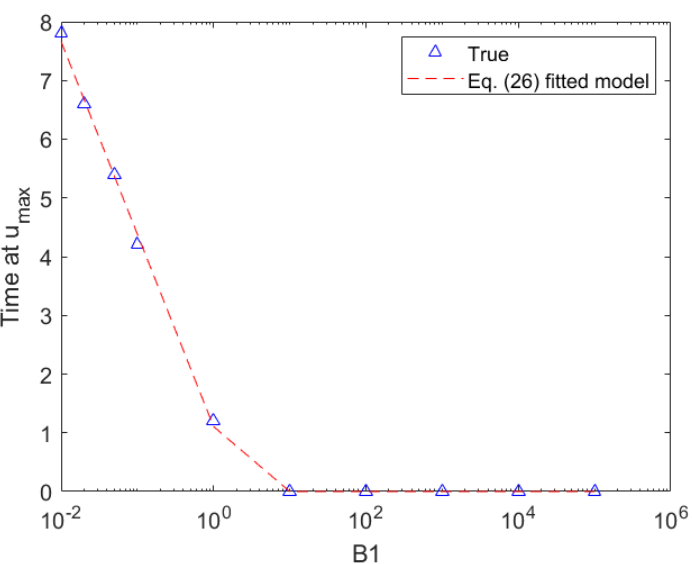
( ) u t to stay at its maximum, max t , against the